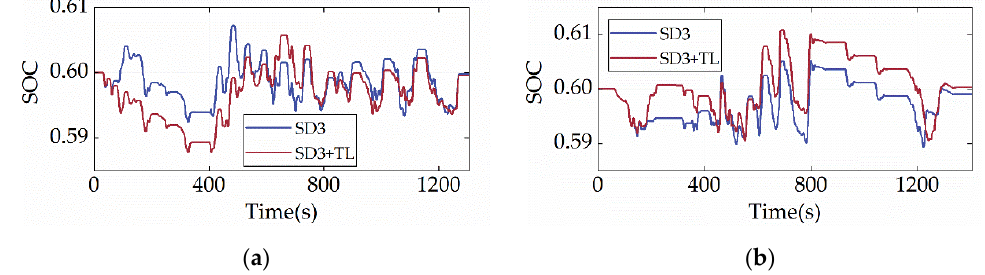
Figure 19. SOC trajectories under different driving cycles. ( a ) CHTC-B; ( b ) WVUCITY.